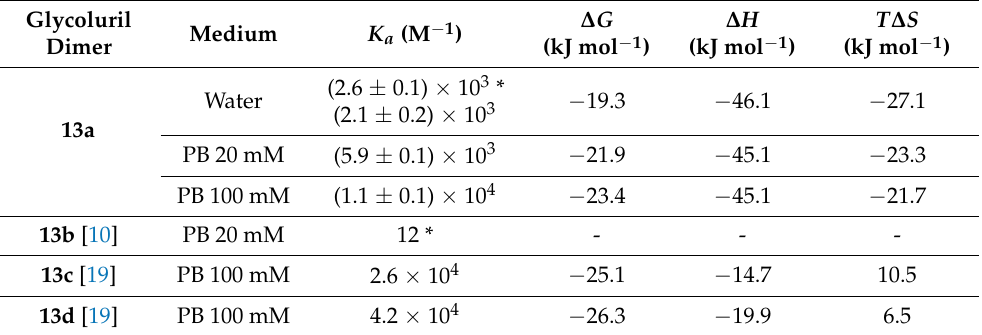
Table 1. Association constants and thermodynamic parameters of the 13a dimer and their comparison with previously reported values for dimers of 13b [10], 13c [19], and 13d [19] in water and phosphate buffer (PB) solutions. Most values were determined using ITC, values obtained by NMR titrations are marked with asterisks ( *